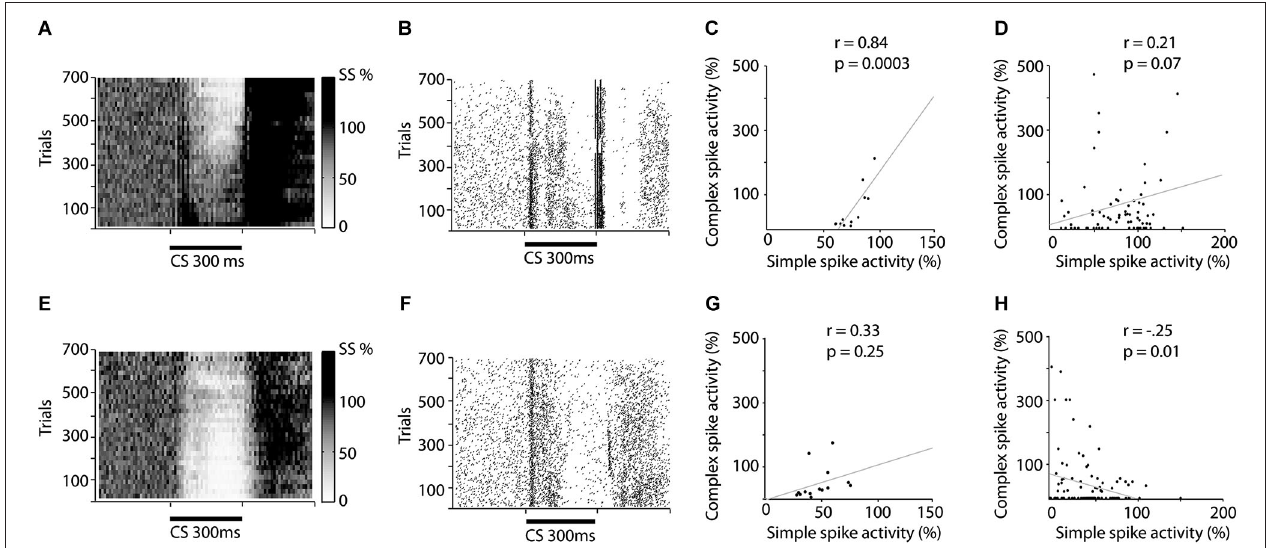
activity during training. Each dot represents a complex spike and each row represents one trial. ( C and G ) Correlation between the average simple spike frequency and complex spike frequency. Each dot represents the relative simple spike frequency 150–250 ms after CS onset, in a 50 trial bin and the relative complex spike activity 200–300 ms after CS onset in the same 50 trials. ( D and H ) Correlation between un-pooled simple and complex spike